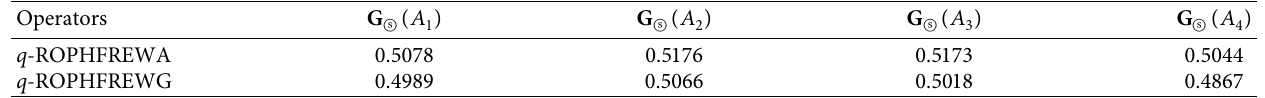
Table 5: Score values.